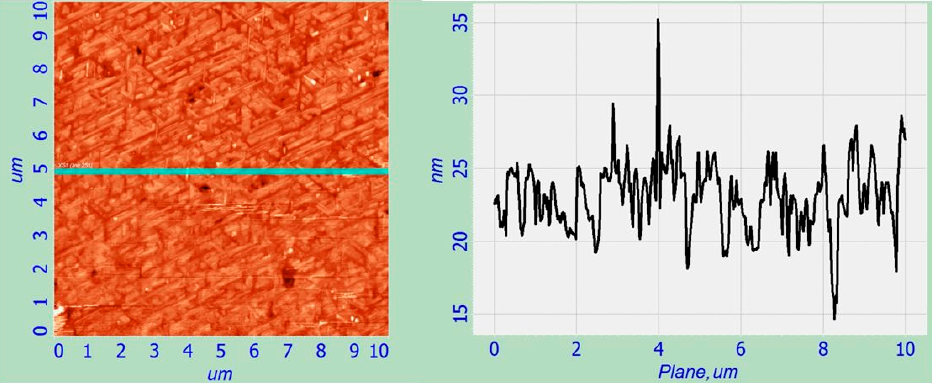
Figure 11. AFM surface image and the surface profile taken in the line for region L1. Two types of islands are observed on the L1 surface: islets of chaotic shape with an average lateral size of 200–300 nm, 4–6 nm high and islets as nanowhiskers with an aver- age length of 0.5 to 1 µm and 6–10 nm high, which have a strict orientation and line up along the direction of {110}, due to the heterogeneous nucleation on the Si (111) substrate and subsequent growth. Electron irradiation after CaF 2 growth (region L2) leads to the formation of CaSi 2 nanowhiskers with an average size of 5 µm, inside which there are separate islands of 60– 70 nm in size and 15–20 nm in height. At the same time, it is impossible to distinguish any predominant directions or their connections with the Si (111) substrate. The surface profile was obtained using the AFM method and is shown in Figure 12. When the formed CaF 2 film is irradiated with an electron beam, a chaotic homogeneous nucleation occurs, fol- lowed by the crystallite growth in all directions. Figure 12. AFM surface image and the surface profile taken in the line for region L2. The average surface roughness in the irradiation area for the region L1 is 6–8 nm and for L2—25–30 nm. 4. Discussion It was found that irradiation during the epitaxial CaF 2 -film growth leads to the het- erogeneous nucleation and growth of Si-related nanowhiskers CaSi 2 , oriented along the direction <1–10> with average size 5 um. Irradiation of the formed epitaxial CaF 2 film with a thickness of 10 nm at a similar electron irradiation dose and substrate temperature leads to random CaSi 2 nucleation cen- ters in CaF 2 film with a subsequent crystallite proliferation. Analysis of the RHEED and SEM patterns shows that disordered CaSi 2 crystallites are present on the surface. This